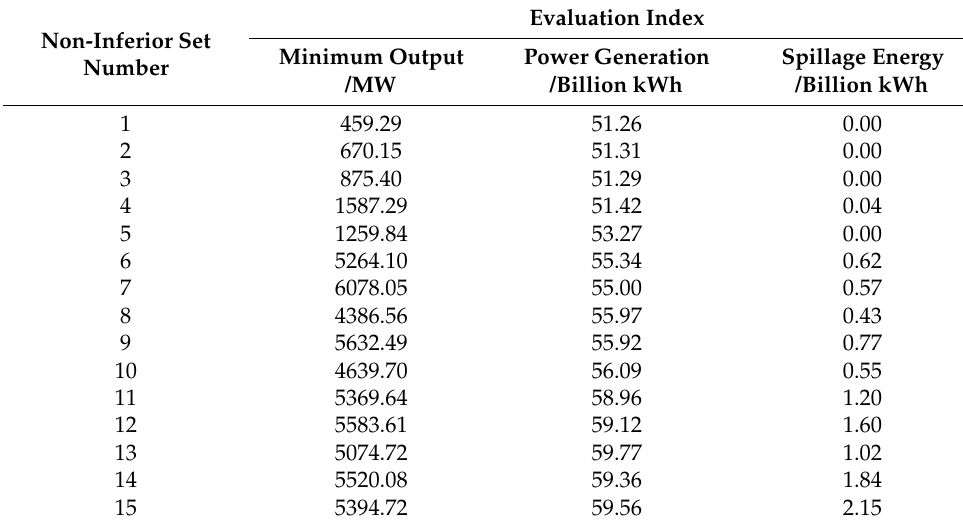
Table 4. Evaluation index of non-inferior solution set.